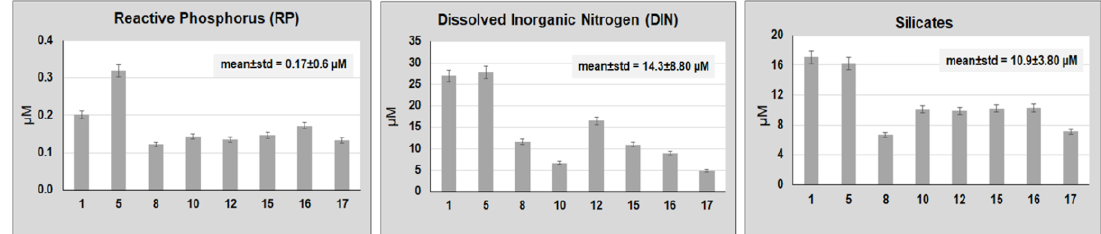
Figure 6. Concentration of reactive phosphorus, dissolved inorganic nitrogen, and silicates in the eight stations monitored monthly during one year.